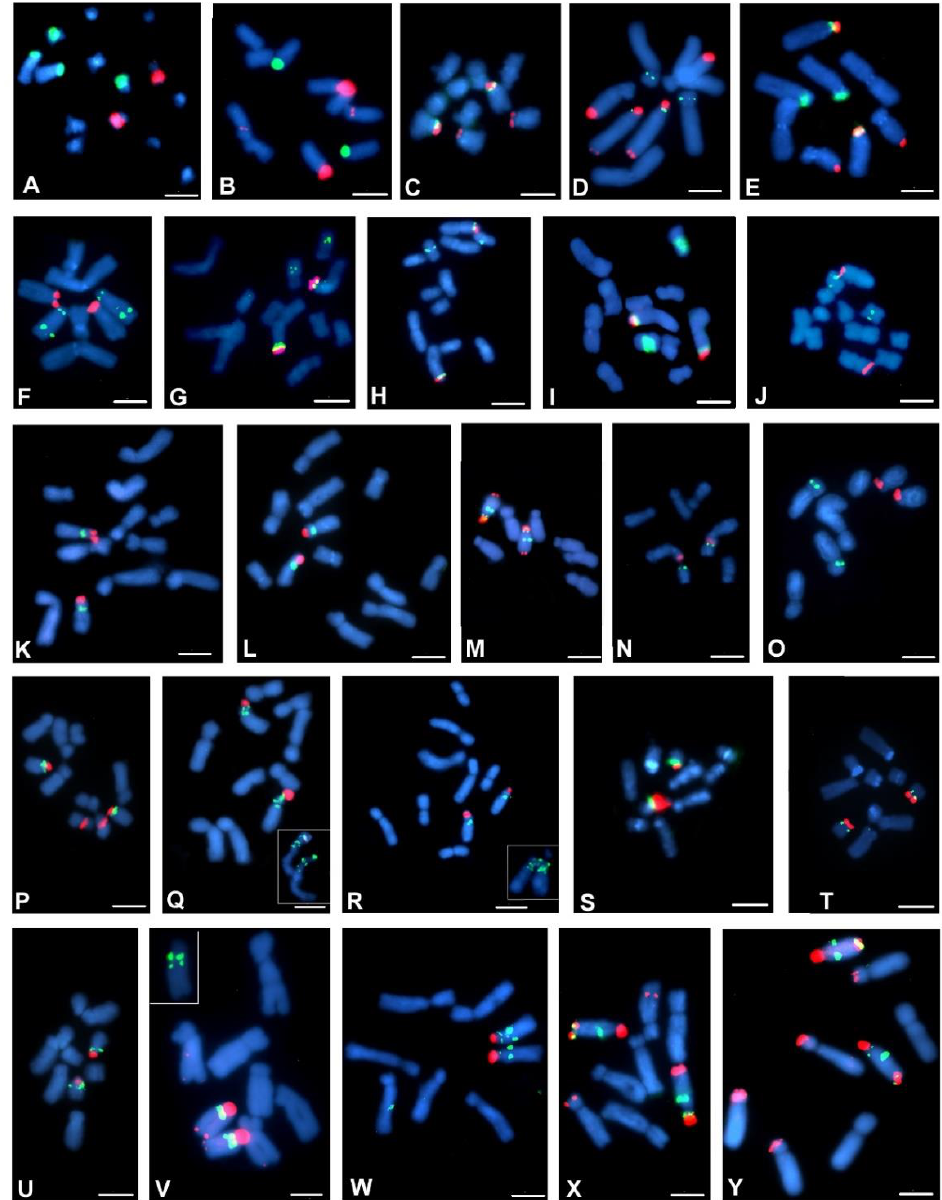
Figure 4. Localisation of 35S and 5S rDNA loci in metaphase chromosomes of Crepis species. Fluorescent in situ hybridisation was performed with the 5S rDNA probe (green fluorescence) and 25S rDNA probe (red fluorescence). ( A ) Lapsana communis , ( B ) C. magellensis , ( C ) C. sancta , ( D ) C. palaestina , ( E ) C. pulchra , ( F ) C. praemorsa , ( G ) C. succisfolia , ( H ) C. mollis , ( I ) C. pygmeae , ( J ) C. lyrata , ( K ) C. paludosa , ( L ) C. jacquinii , ( M ) C. dioscoridis , ( N ) C. zacintha , ( O ) C. kotschyana , ( P ) C. rubra , ( Q ) C. foetida subsp. rhoaedifolia , ( R ) C. foetida , ( S ) C. sibirica , ( T ) C. syriaca , ( U ) C. alpina , ( V ) C. chondrilloides , ( W ) C. lacera , ( X ) C. pannonica 1 and ( Y ) C. pannonica 2. Scale bar = 5 µm.